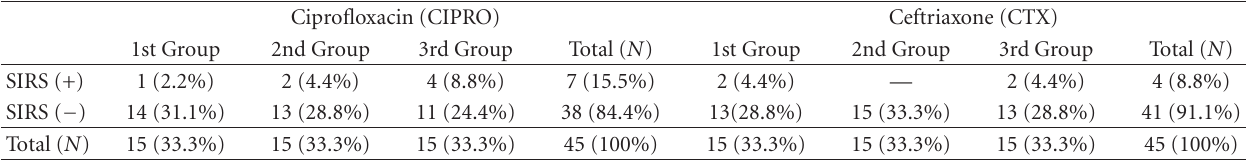
Table 1: Number of SIRS cases among antibiotic groups.